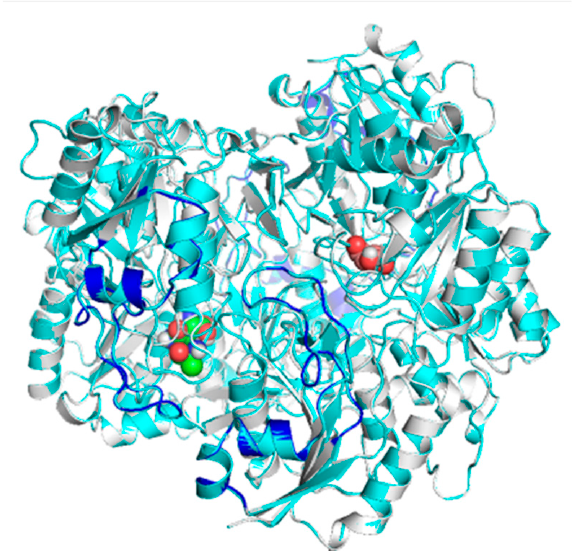
Figure 6. Alignment of the N-terminal end of chimeric humanized E. coli L-asparaginase with fragments of human L-asparaginase 4O0H with the N-terminal of the native E. coli protein. The N-terminal end that forms the loop that blocks the active center regulating substrate entry and product exit is shown in blue. There is a 100% structural match with no bends or chain breaks.